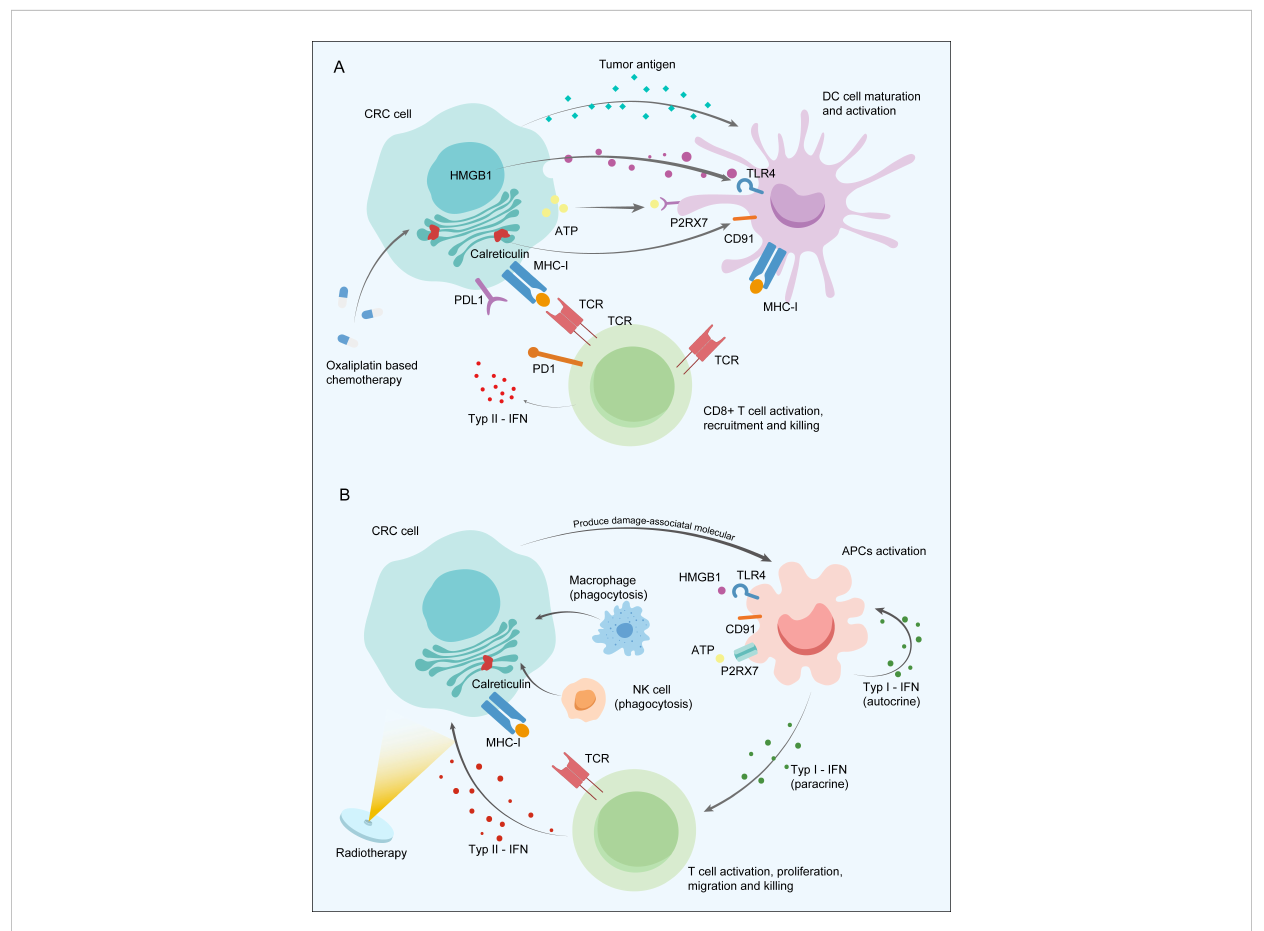
FIGURE 2 Potential synergistic mechanism between neoadjuvant immune checkpoint inhibitor and neoadjuvant chemotherapy (A) and radiotherapy (B) in colorectal cancer. APCs, Antigen-presenting cells; ATP, Adenosine triphosphate; CRC, Colorectal cancer; HMGB1, High-mobility group box 1 protein; IFNs, Type I interferons; MHC-I, Major histocompatibility complex class I; NK cells, Natural killer cells; P2RX7, Purinergic Receptor P2X 7 PD- 1; Programmed death-1; PD-L1, Programmed death-ligand 1; TCR, T-cell receptor; TLR4, Toll Like Receptor